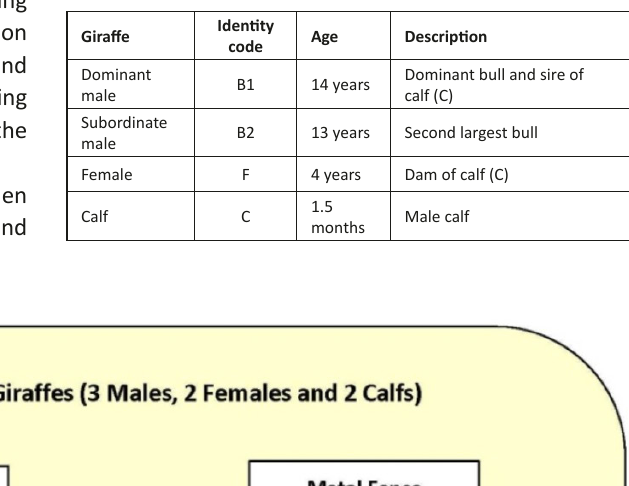
Table 1. Details of subjects involved in the observational study at Zoological Garden Alipore,